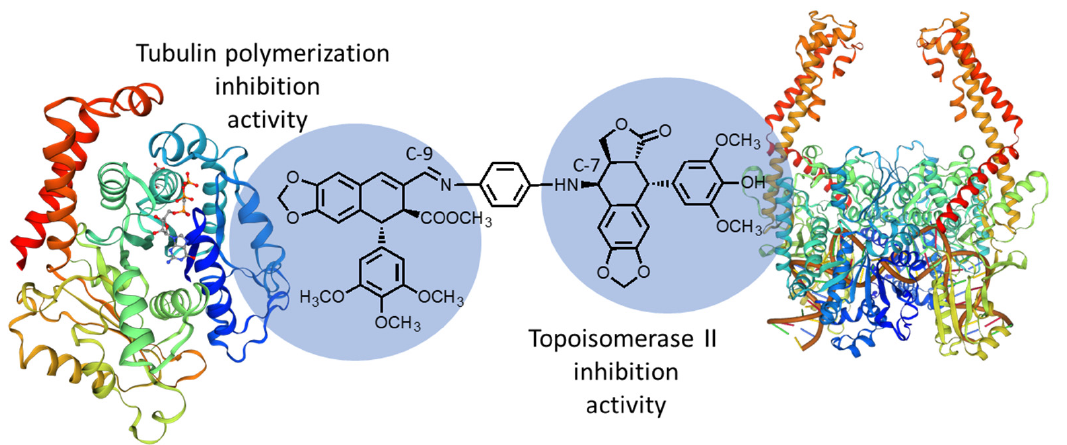
Figure 2. Schematic representation of 7 β ,9-biscyclolignan, formed by two cyclolignan fragments connected through a diamine spacer.